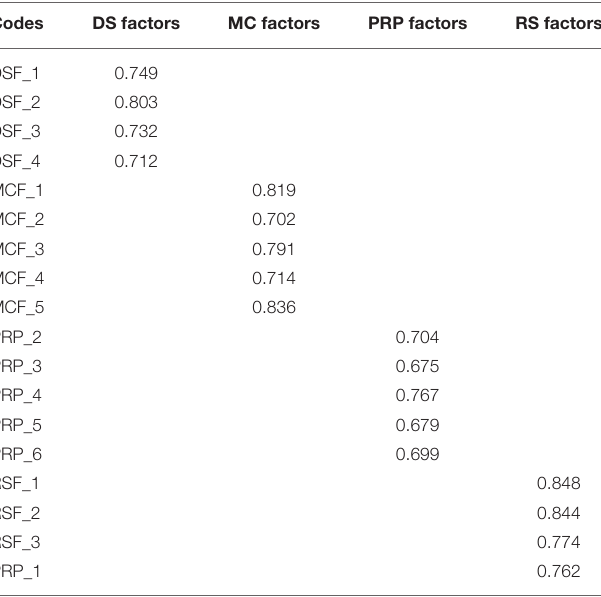
TABLE 6 | Outer-loadings results. TABLE 7 | Construct reliability and